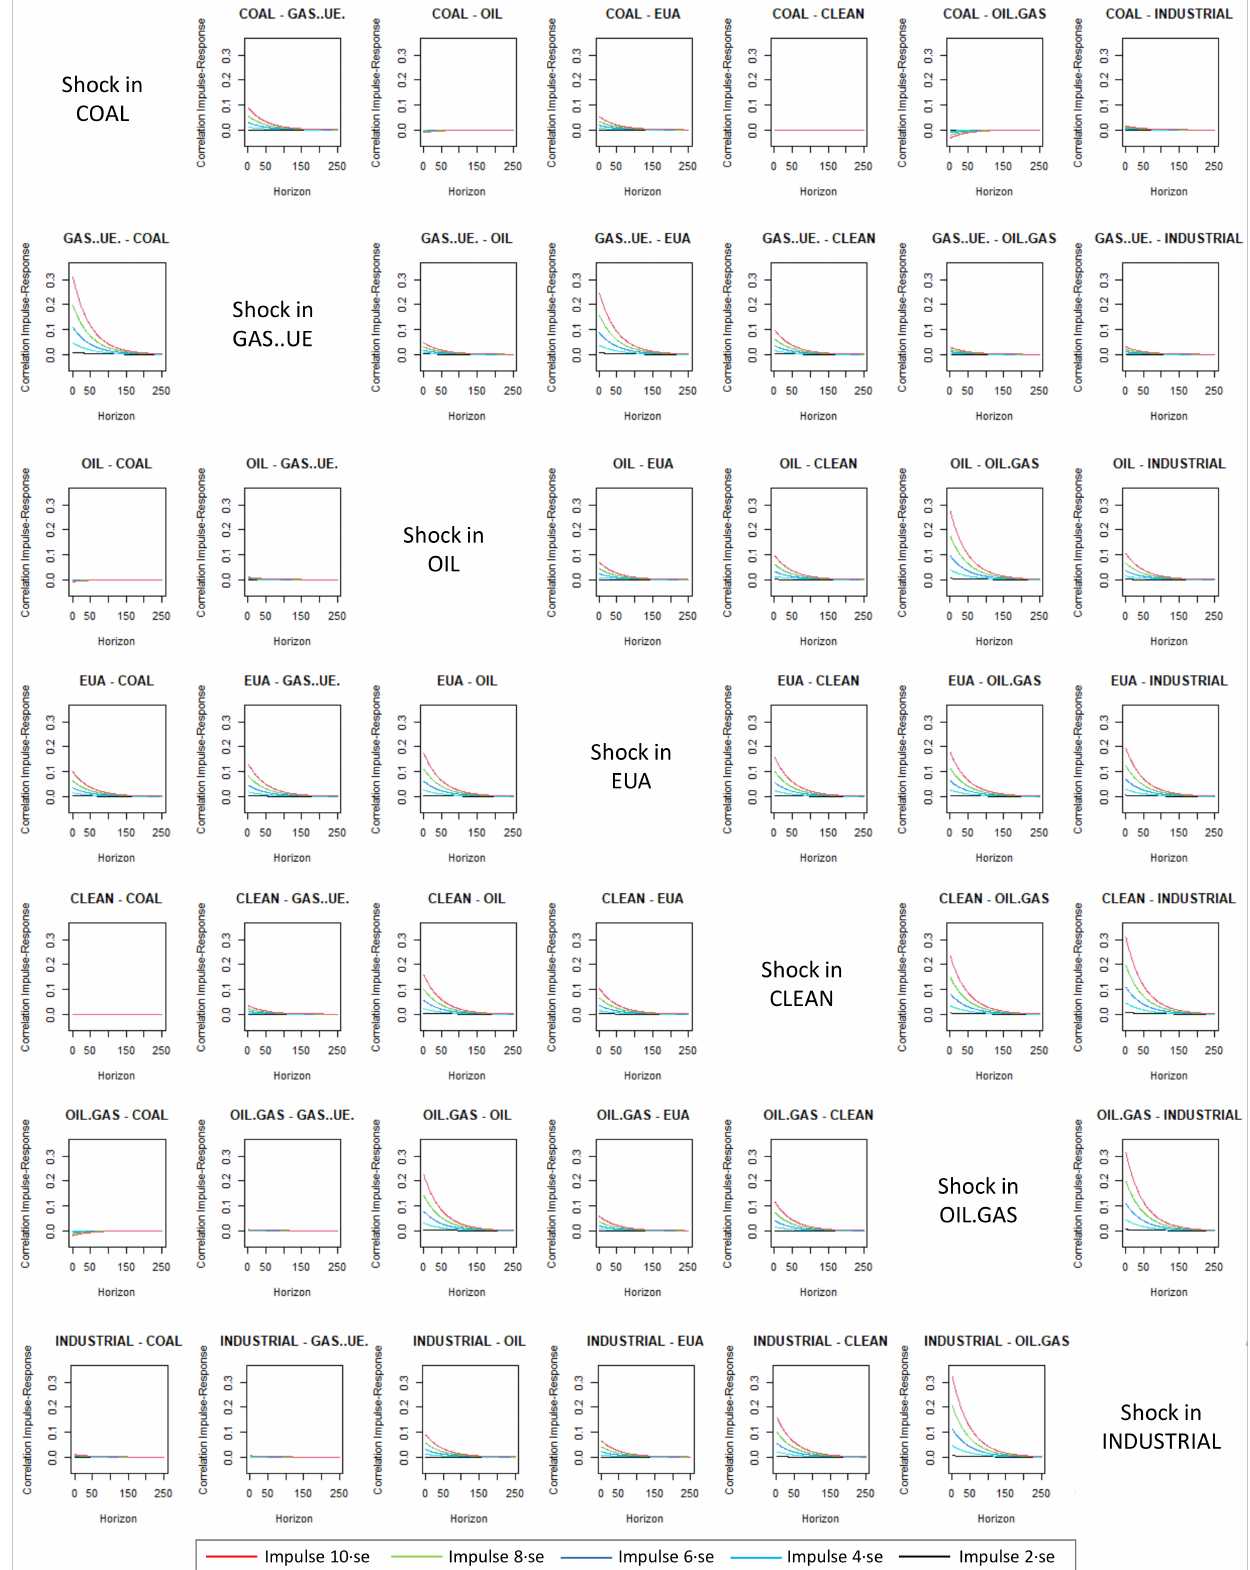
Figure 8. Matrix graph with the conditional correlation impulse response curves for several forecast horizons and shock sizes. The off-diagonal cells of each row contain the response of the correlation between the shocked variable and each of the others. The diagonal cells specify the shocked